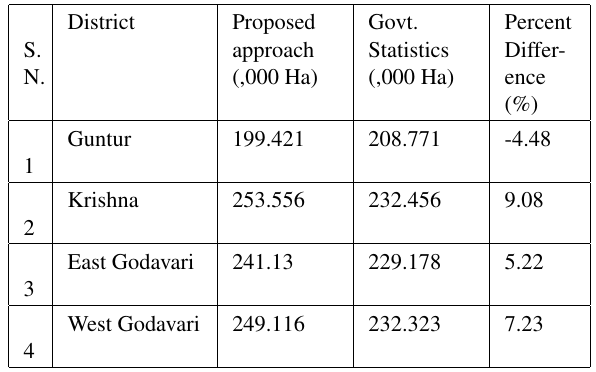
Table 2. Comparison of area obtained using proposed approach with government